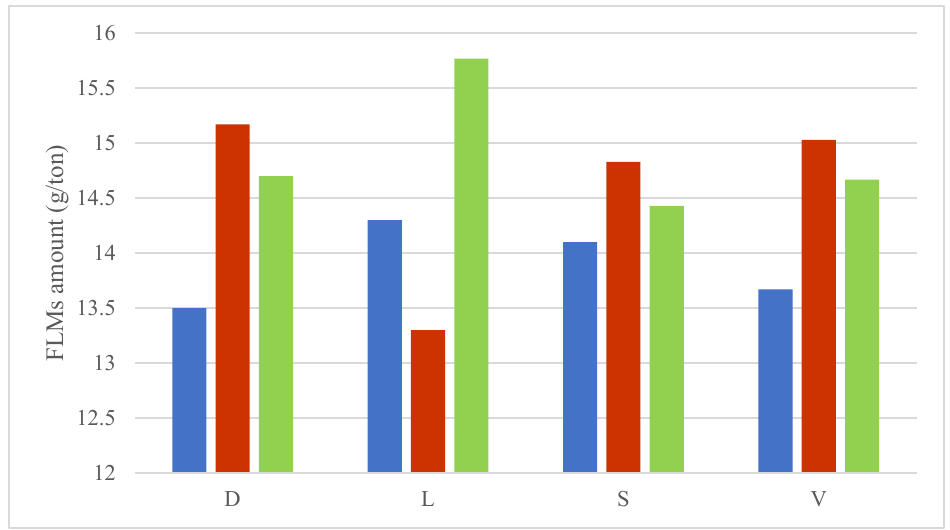
Figure 8. Range analysis of different factors by LFM amount.